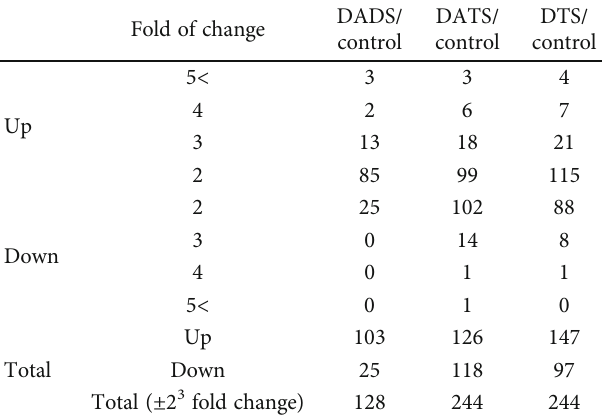
Table 1: Changes of DSs-related gene expression in Hep G2 cells. Fold of